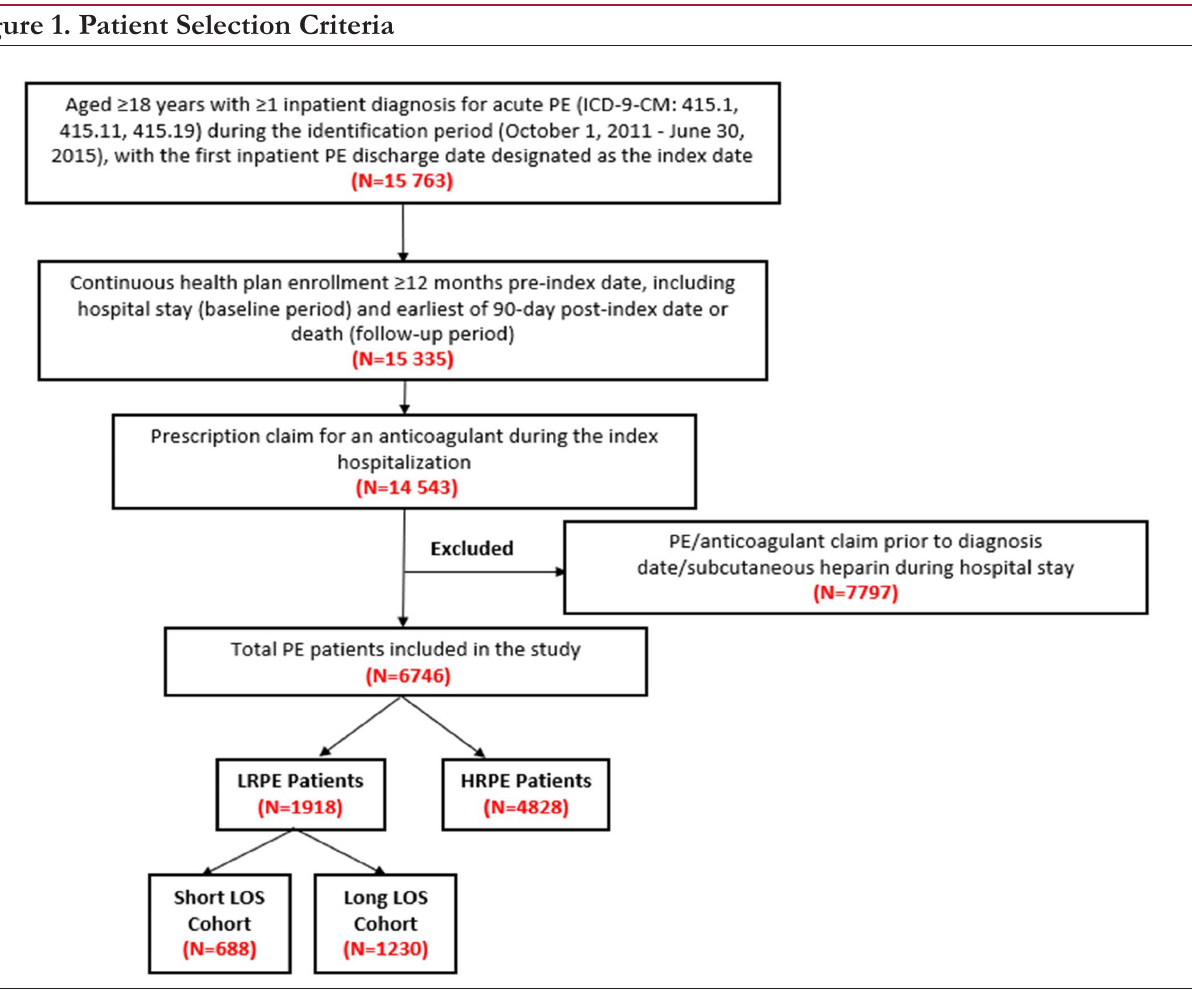
Figure 1. Patient Selection Criteria